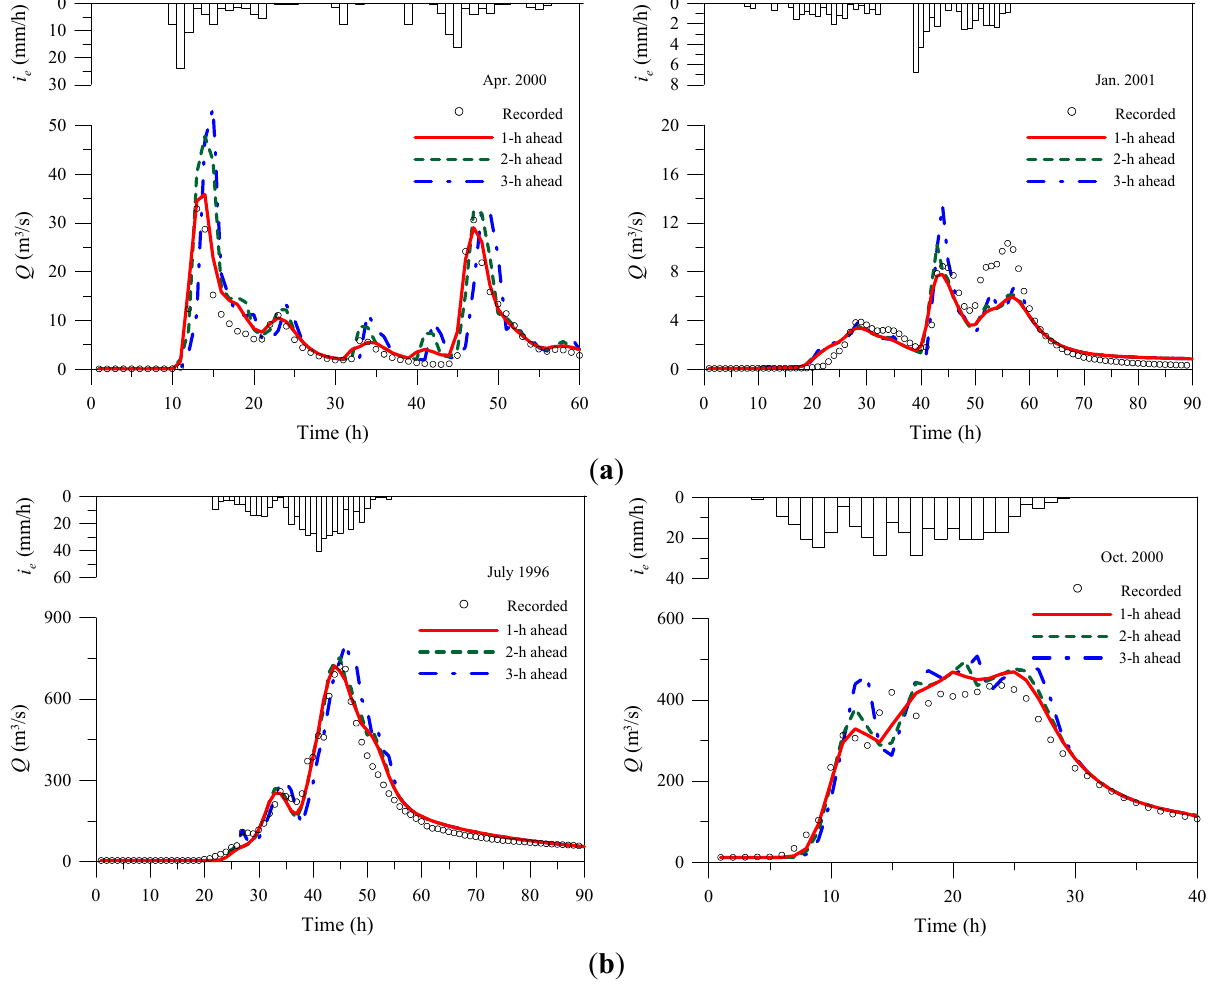
Figure 7. Flow forecasting using forecast rainfall and without flow updating in Goodwin Creek and San-Hsia watersheds: ( a ) Goodwin Creek watershed (STA